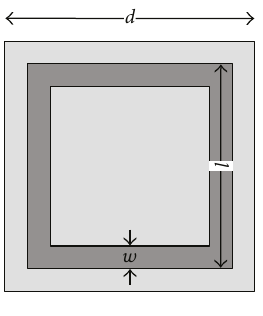
Figure 1: Pyramidal horn antenna. Figure 2: CSR unit